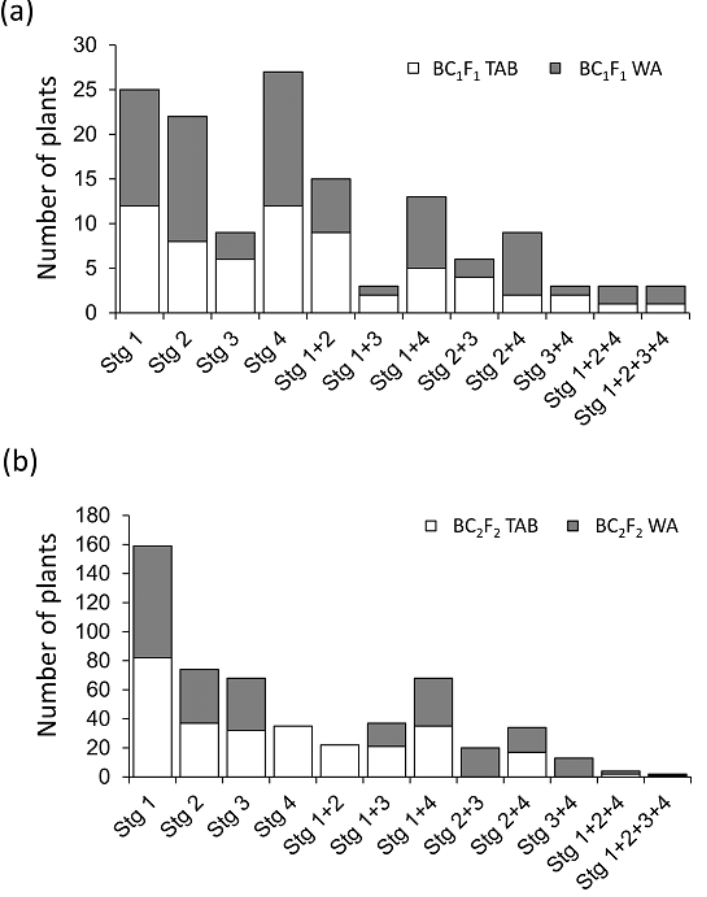
Figure 2. Proportion of stay-green QTL combinations in ( a ) BC 1 F 1 and ( b ) BC 2 F 2 ‘Tabat’ (TAB) and ‘Wad Ahmed’ (WA) populations.